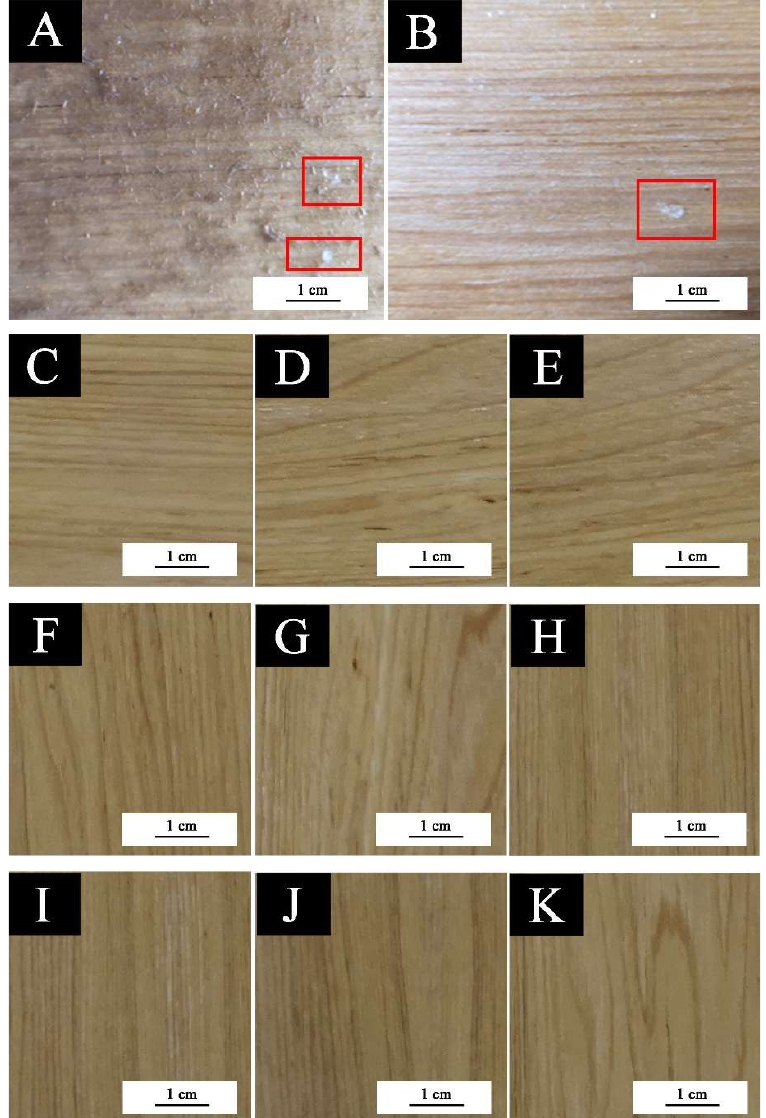
Figure 11. Trichoderma grew on the surface of wood substrates: ( A ) waterborne coating; waterborne coating with di ff erent concentrations of WSPALR: ( B ) 0.5%; ( C ) 1.0%; ( D ) 2.0%; ( E ) 3.5%; ( F ) 5.0%; and waterborne coating with di ff erent concentrations of calcined WSPALR: ( G ) 0.5%; ( H ) 1.0%; ( I ) 2.0%; ( J ) 3.5%; ( K )